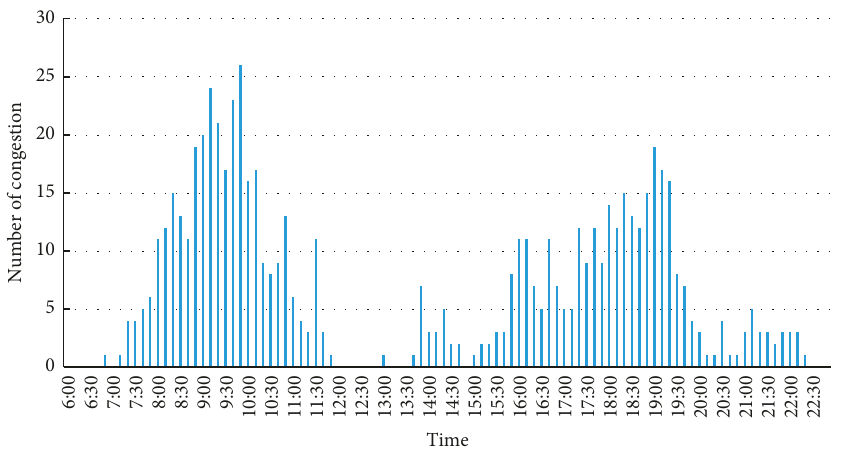
Figure 14: Trend of congestion